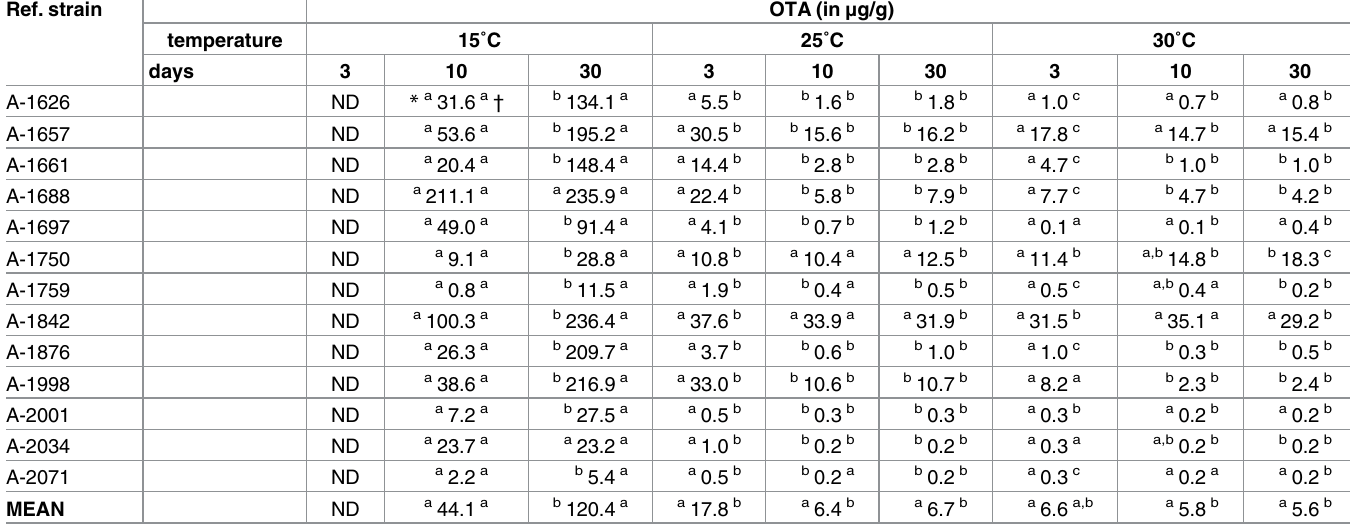
Table 2. Ochratoxin A (OTA) concentration (mean value in μ g/g) detected in the 13 ochratoxigenic strains in CYA at each temperature and incuba- tion time tested. Ref. strain